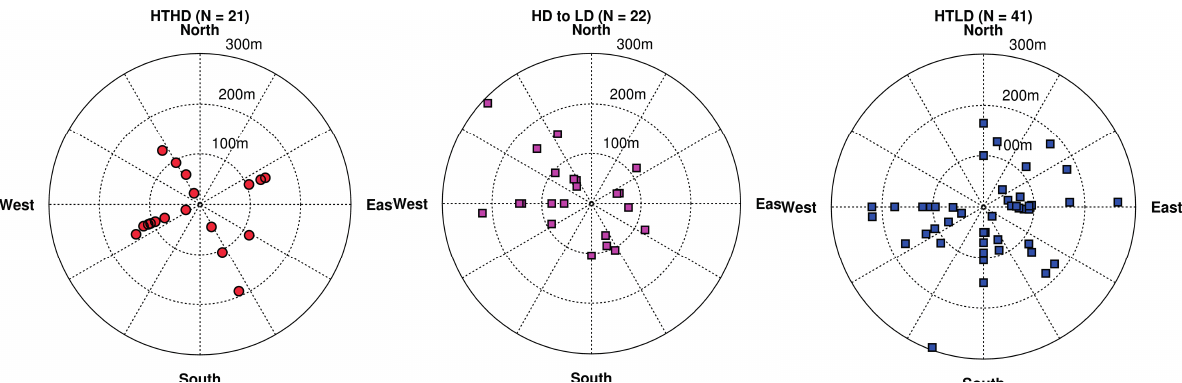
Figure 14. Locations of study participants’ homes with respect to the roadways in the high-traffic (HT), high-diesel (HD) group (left panel); participants previously classified in the HD group who were switched to the low diesel (LD) group (middle panel); and participants in the LD group (right panel). Radial distances represent the perpendicular distance from the roadway to the study participants’ home